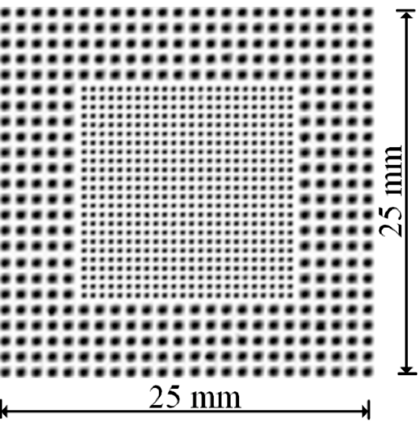
Figure 3. Image of a resolution test chart acquired by 1064 nm Raman spectral imaging